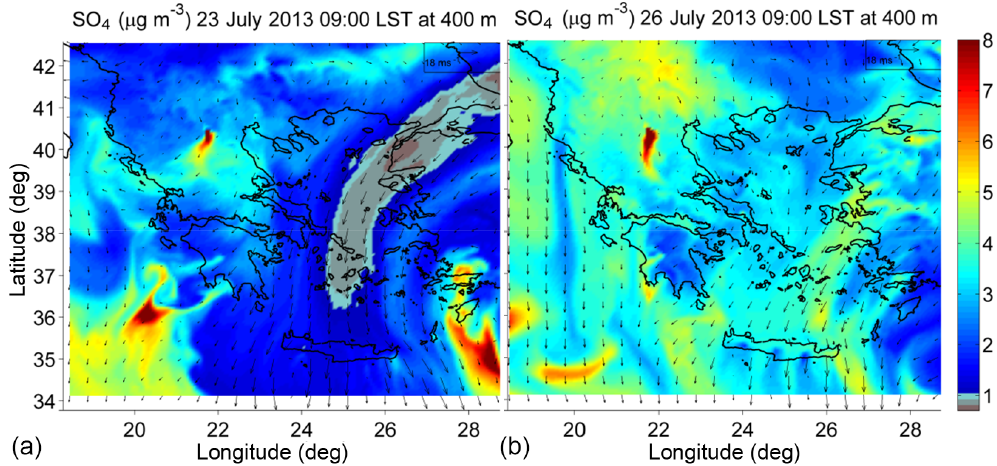
Figure 7. As in Fig. 5, but for sulfate concentration (µgm − 3 ) at 09:00 LST.